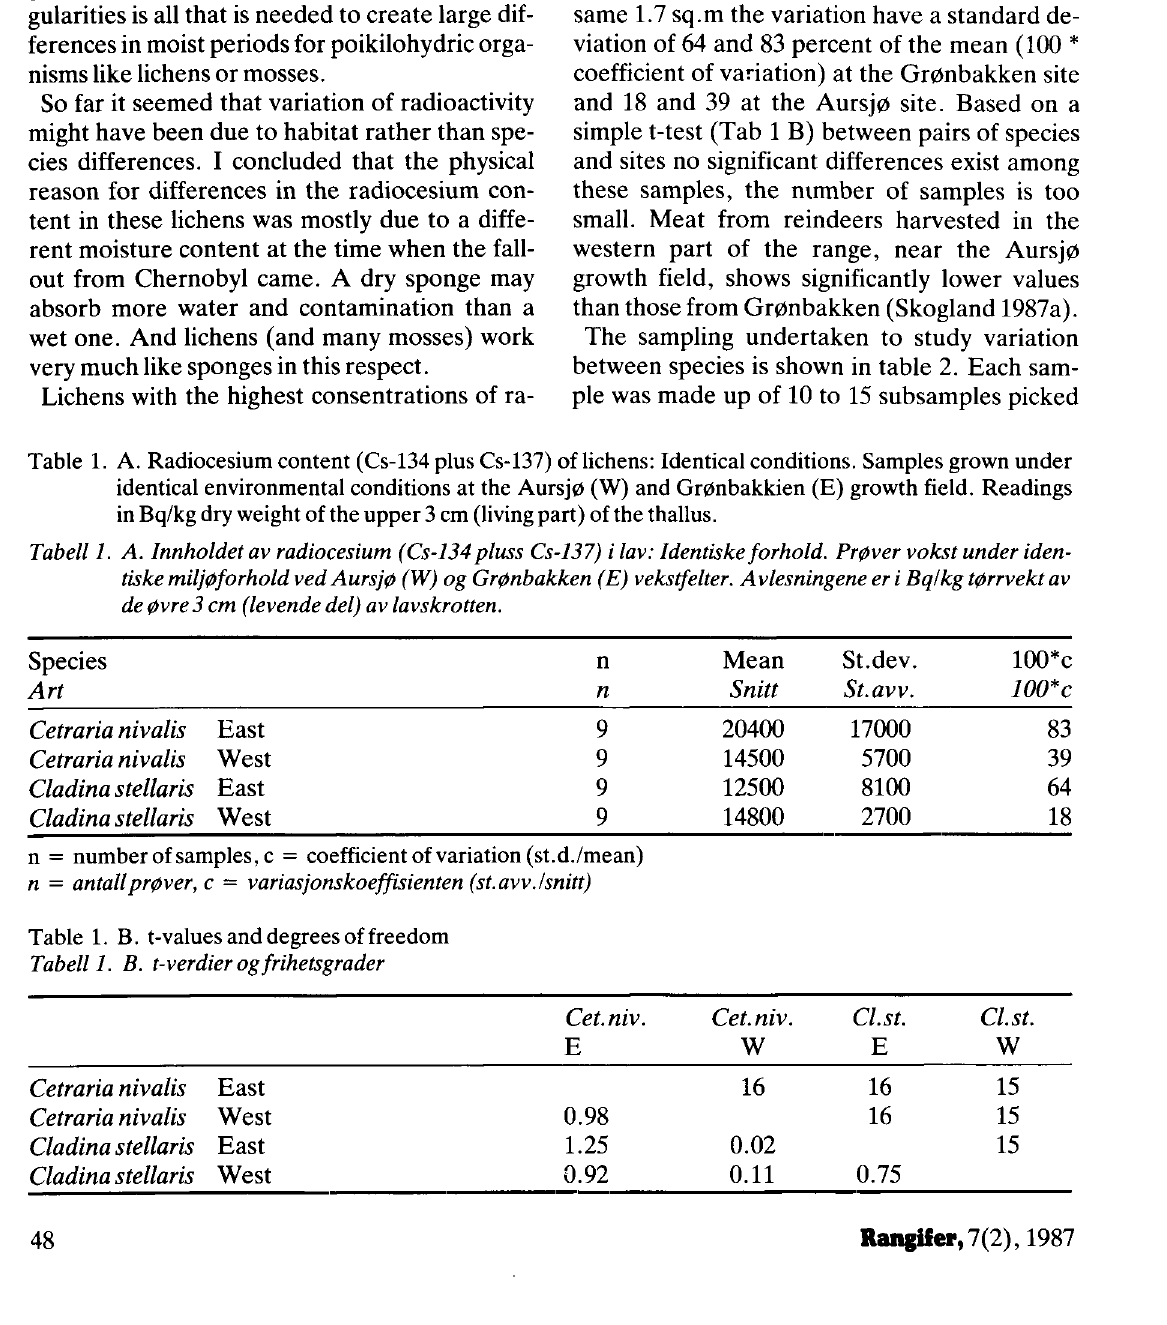
Table 1. B. t-values and degrees of freedom Tabell 1. B. t-verdier og